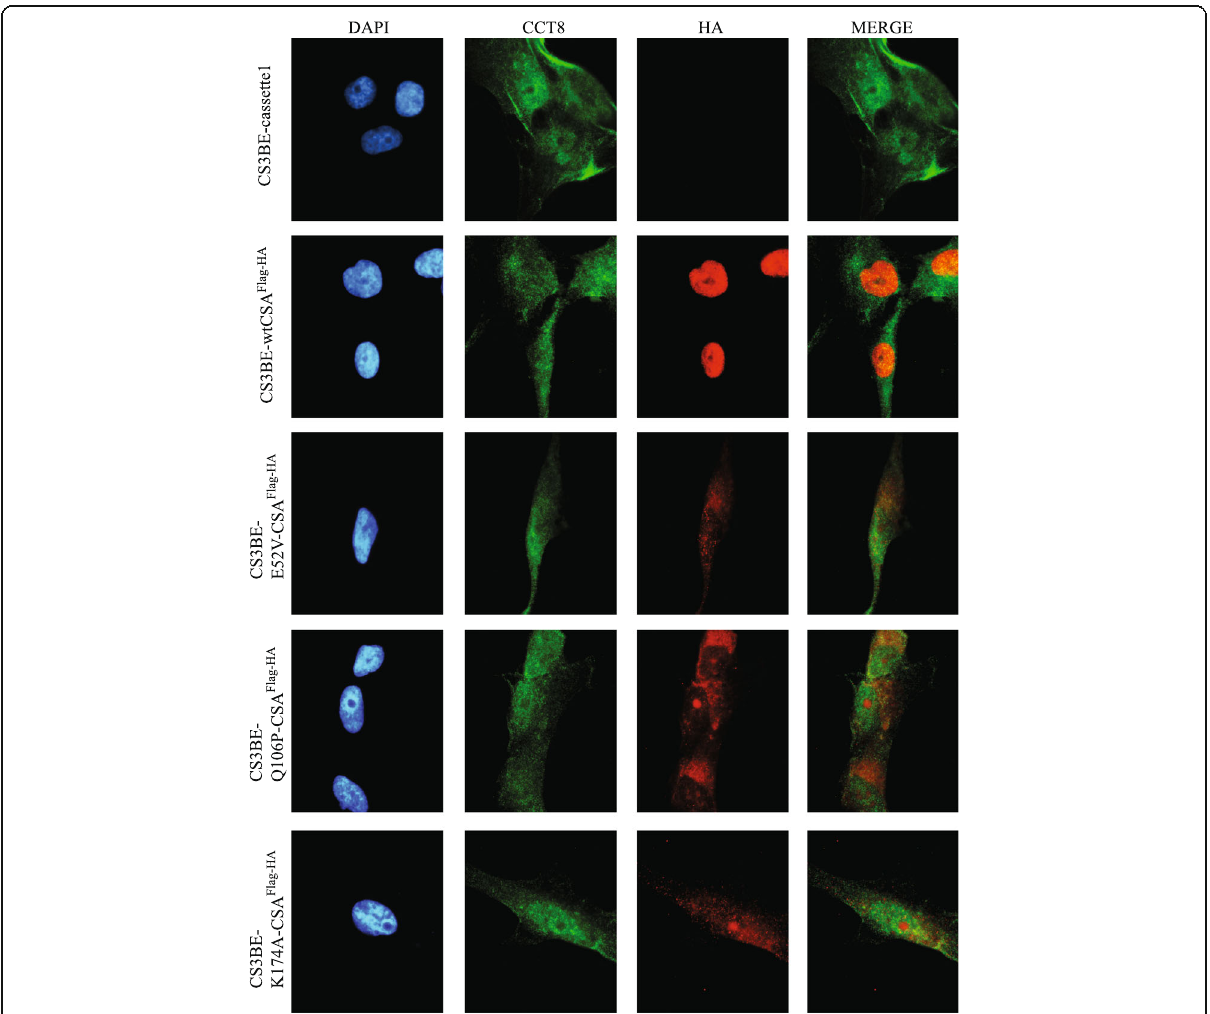
Fig. 2 Subcellular co-localization of the recombinant CSA Flag-HA proteins with CCT8 subunit. Double immunofluorescence staining with anti-HA antibodies ( red ) and anti-CCT8 ( green ) in CS3BE-cassette1, CS3BE-wtCSA Flag-HA , CS3BE-E52V-CSA Flag-HA , CS3BE-Q106P-CSA Flag-HA , and CS3BE-K174A- CSA Flag-HA . Nuclei were counterstaining with DAPI ( blue